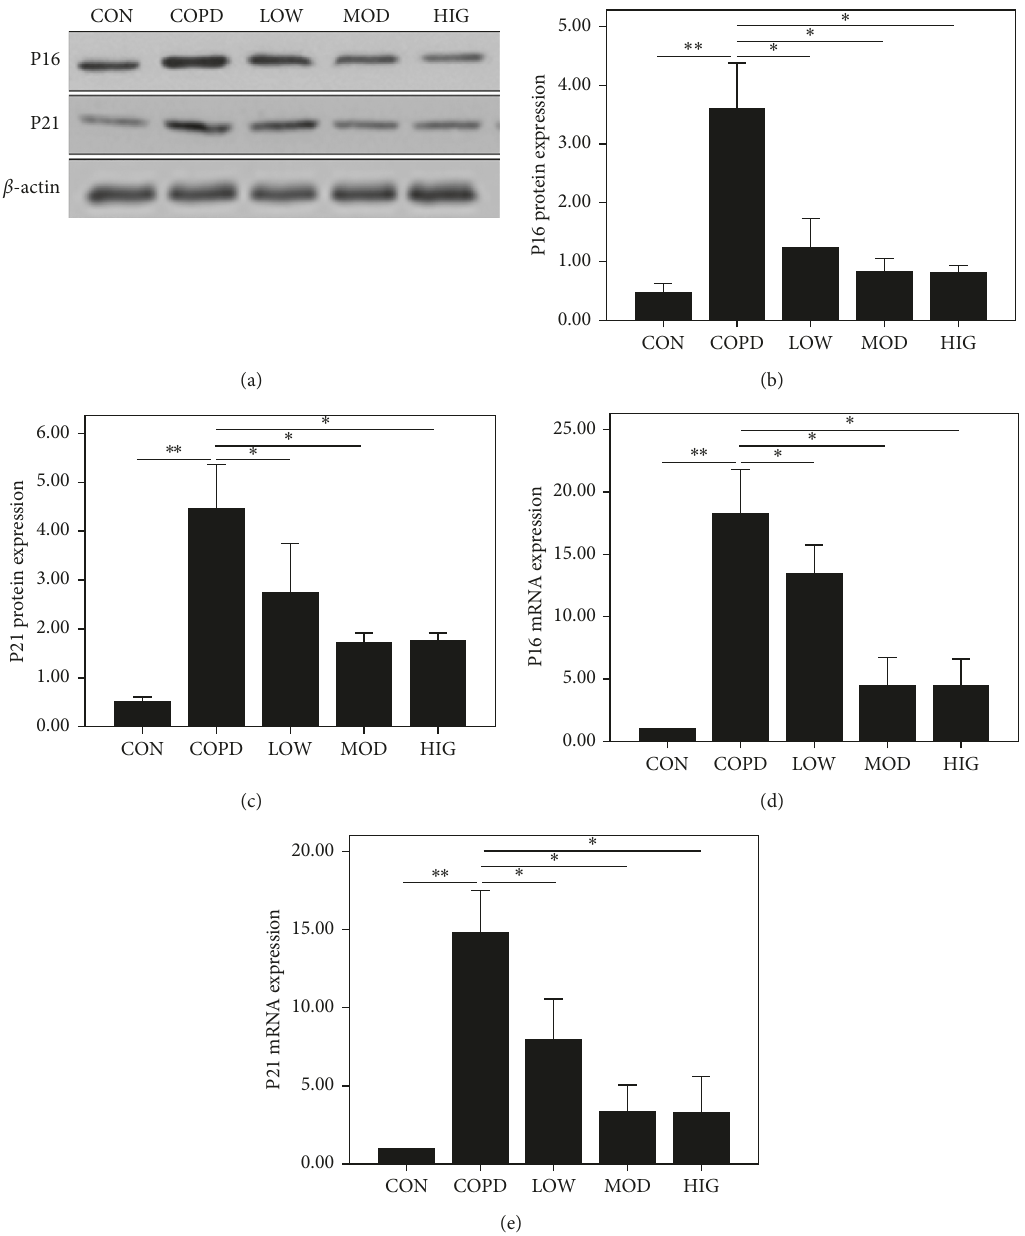
Figure 3: The expression of P16 and P21 in lung tissue of COPD rat models were inhibited by O. sinensis . (a) The expression of P16 and P21 in lung tissue of all the groups were detected by western blotting. The quantitative analysis of P16 (b) and P21 (c) in lung tissue of the COPD group and COPD+CS group was conducted. The mRNA expression of P16 (d) and P21 (e) in lung tissue of the COPD group and COPD+CS group was analyzed by